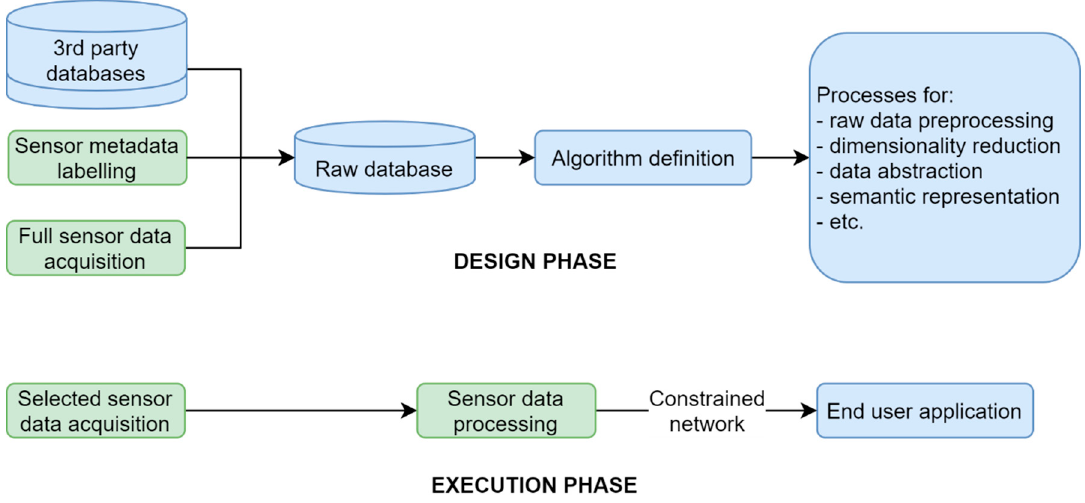
Figure 1. Data constraints in the design and execution phases.